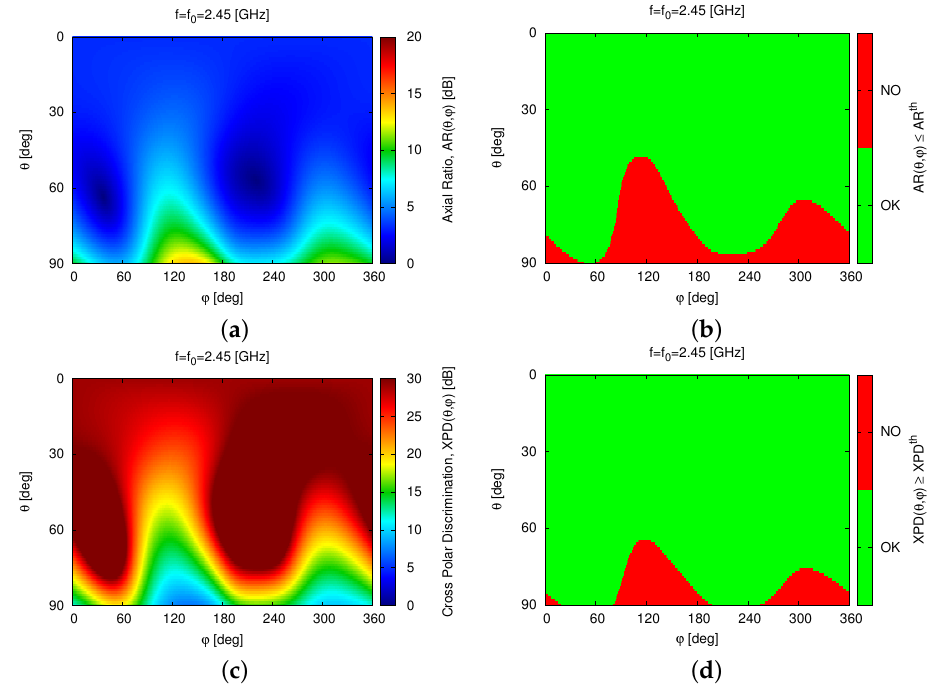
Figure 8. Numerical Assessment ( [ f min , f max ] = [ 2.3, 2.6 ] [GHz], f = f 0 = 2.45 [GHz])—Absolute ( a , c ) and thresholded ( b , d ) 2D maps of the simulated ( a , b ) axial ratio, AR ( f 0 , θ , ϕ ) , and ( c , d ) cross- polar discrimination, XPD ( f 0 , θ , ϕ ) , in the complete upper half-space of the WWCS antenna. In order to assess the excitation of a LHCP , the plot of the magnitude of the instantaneous (cid:12) (cid:12) (cid:12) (cid:12) ( x , y ; t ) surface current density, (cid:12) , is reported in Figure 9 at four consecutive instants (cid:12) J surf T 0 [i.e., t = 0 [sec]—Figure 9a; t = T 0 [sec]—Figure 9b; t = T 0 [sec]—Figure 9c; t = 3 8 4 8 [sec]—Figure 9d T 0 being the period at f 0 , T 0 = 1 ]. One can observe that the fundamental f 0 mode TM 11 is properly excited on the circular patch [33] and there is a clock-wise rotation of the corresponding surface current distribution (Figure 9). The vector plot of the electric field distribution at a quota of z = 10 λ 0 , E ( x , y ; t ) , shown in Figure 10 for the same instants, further verifies the desired CP of the radiated wave, which evolves in time according to a LHCP . For comparison purposes, Figure 11 plots the broadside gain G ( f , θ = 0, ϕ = 0 ) [Figure 11a] and the AR AR ( f , θ = 0, ϕ = 0 ) [Figure 11b] within the band of interest of the proposed WWCS model and of the design in [20]. It turns out that the synthesized radiator exhibits a good AR ≤ 6 [dB] [40], that performance, especially within the band f ∈ [ 2.4, 2.6 ] [GHz] where AR | WWCS = 8%, while ARBW | 6 dB = results in an AR bandwidth ( ARBW ) equal to ARBW | 6 dB [ Pan 2014 ] WWCS | 6 dB = 10 times—Figure11b]. Asimilaroutcomeisyielded WWCS 0.8% [i.e., animprovementby ARBW ARBW | 6 dB [ Pan 2014 ] = 3.6% and ARBW | 3 dB = 0.3% [i.e., for the 3 [dB]-bandwidth, as well, since ARBW | 3 dB [ Pan 2014 ] WWCS | 3 dB = 12 times—Figure WWCS an improvement by ARBW ARBW | 3 dB [ Pan 2014 ]